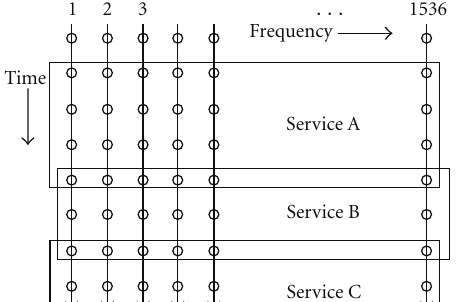
Figure 2: Three services mapped onto consecutive OFDM symbols. Note that there is an overlap between the service since di ff erential modulation is used.